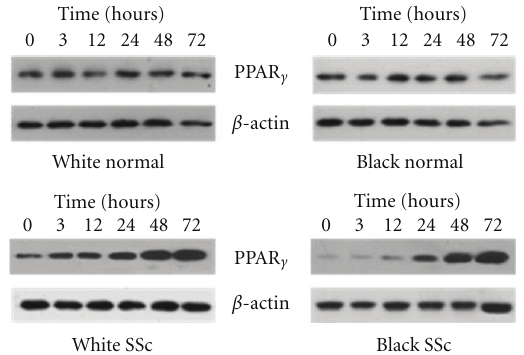
Figure 3: Rosiglitazone increases PPAR γ expression in SSc lung fibroblasts in a time-dependant manner. Lung fibroblasts were incubated with rosiglitazone (20 μ M) for time indicated. Cells were collected and subjected to Western analysis for PPAR γ expression. Anti- β -actin antibody was used as a loading control. Immunoblots are representative from 3 independent